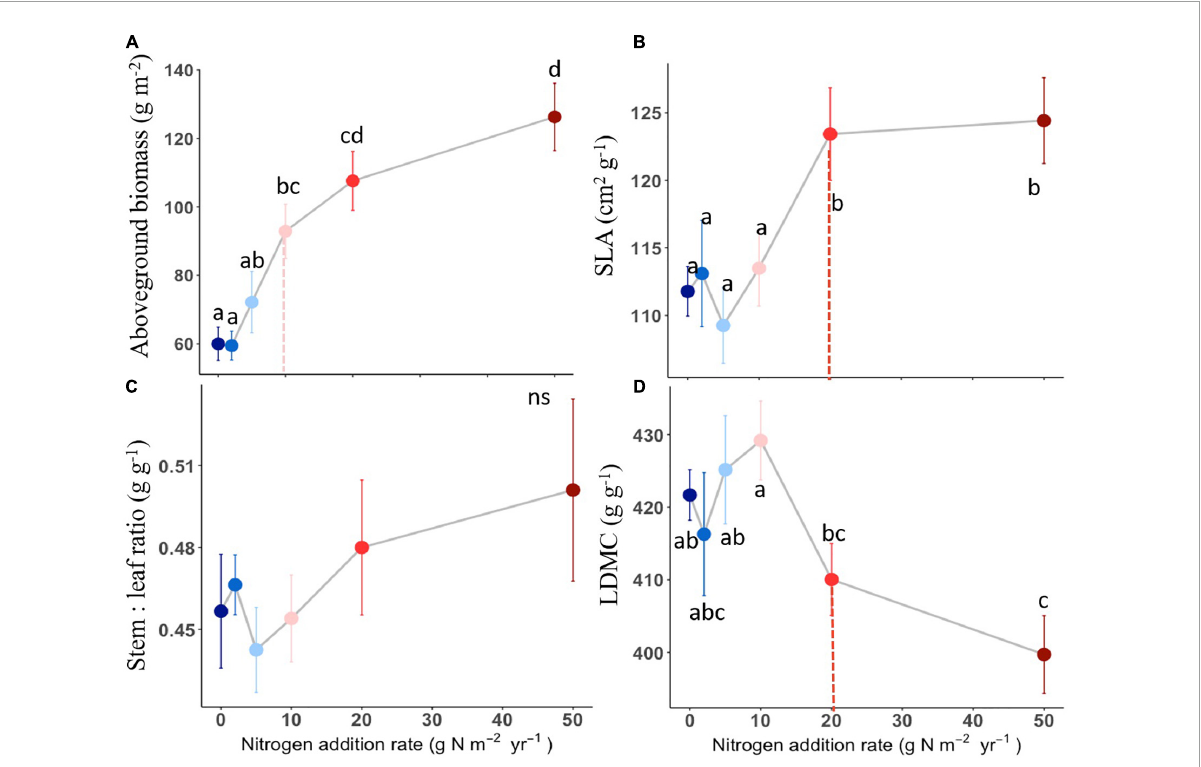
FIGURE1 Effects of N addition on plant biomass and leaf traits of L. chinensis . Trait abbreviations are aboveground biomass (A) , SLA (specific leaf area) (B) , LDMC (leaf dry matter content) (C) and stem: leaf ratio (D) . Different lower-case letters indicate significant differences ( P < 0.05) among treatments, and ns indicates non-significant ( P > 0.05). The dashed line in each panel indicate for tipping points. The data shown are the means with 40 replications ± standard error.